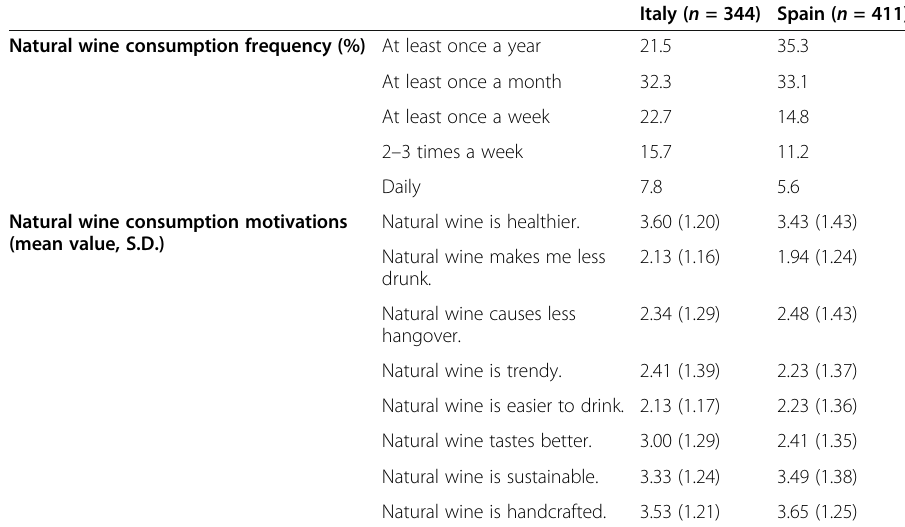
selection procedure) 2 are (i) demographics (gender and age), (ii) variables related to wine drinking behavior (frequency and involvement), (iii) attention towards wine label information (back and front), (iv) self-reported information about natural wine and